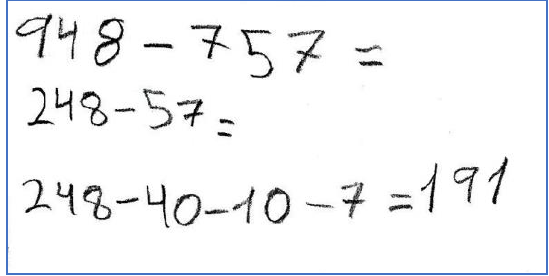
Figure 37. Work out 948 − 757.